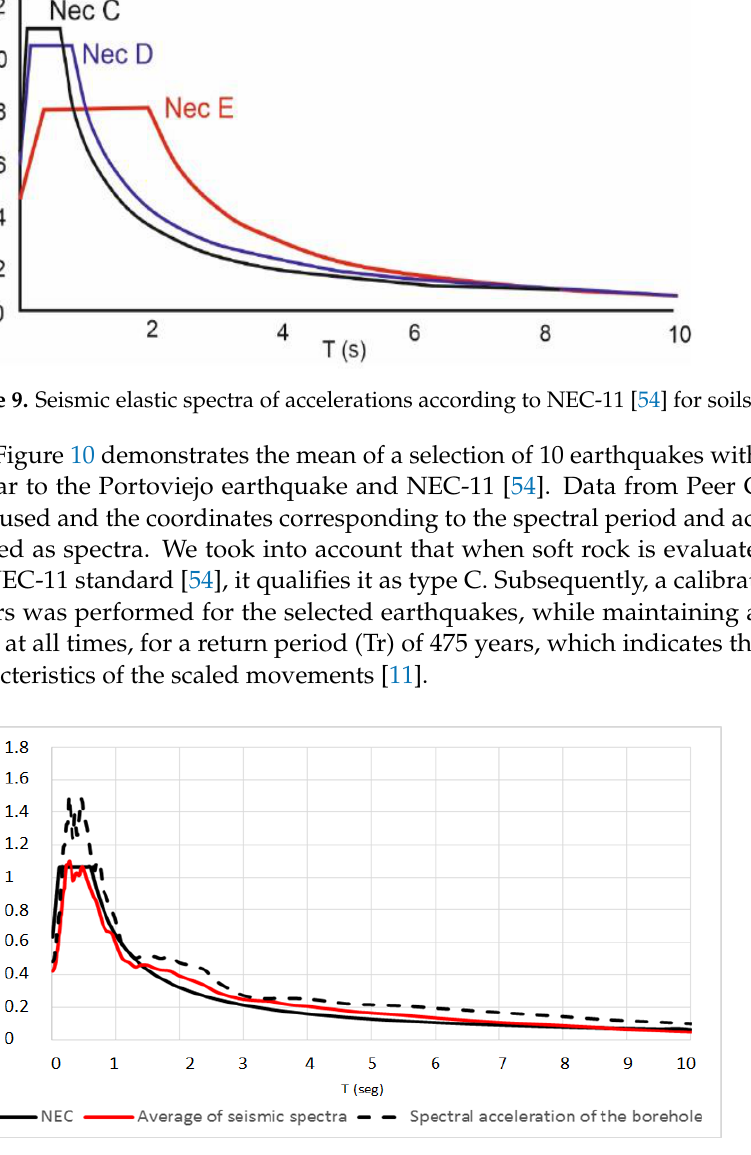
Figure 10. Elastic seismic spectra with acceleration response spectrum for motion at different scales (grey lines).